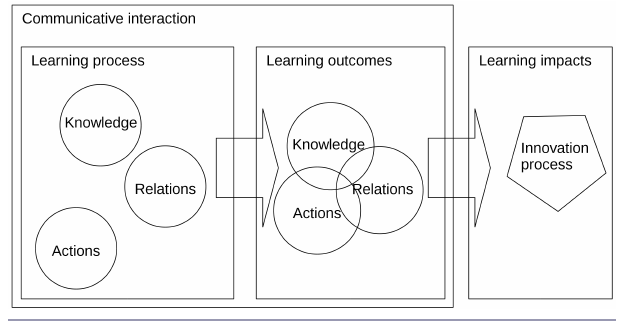
Fig. 1 . Learning as a discursive process with